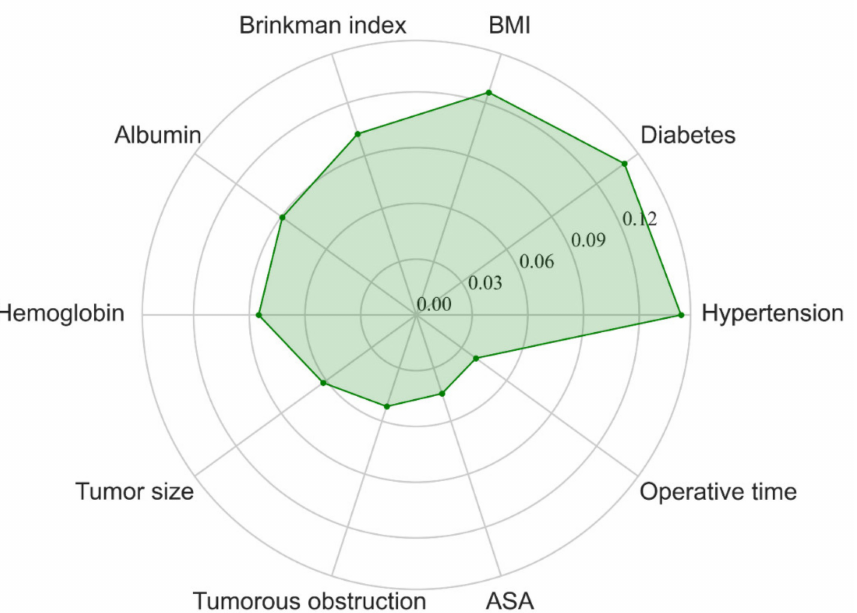
Figure 2. Radar plot for the ten most important variables in predicting AL of the RF model. BMI, body mass index; ASA, American Society of Anesthesiologists classification score; RF, random